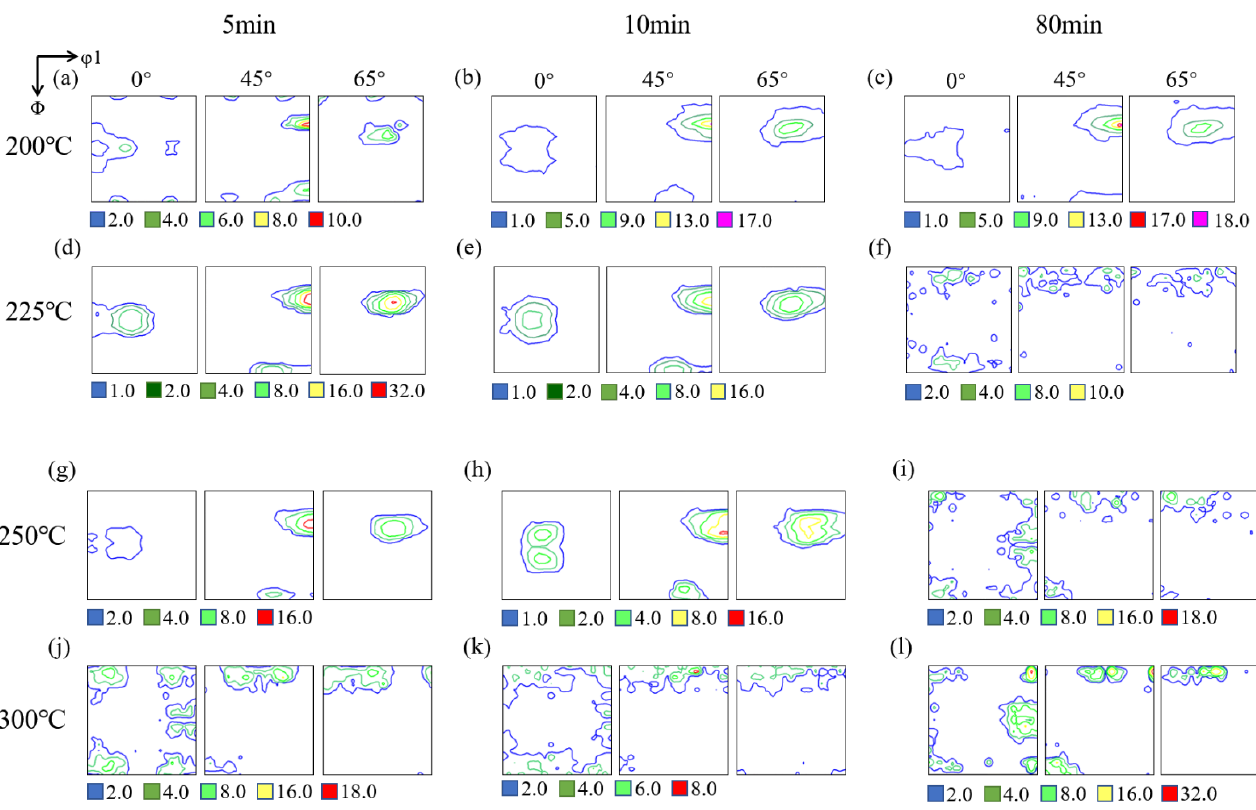
Figure 8. Textures evolution of cold-rolled Al-0.5%Cu samples after annealing in SH, the different colored boxes below represent the intensity of textures: ( a ) 200 °C, 5 min; ( b ) 200 °C, 10 min; ( c ) 200 °C, 80 min; ( d ) 225 °C, 5 min; ( e ) 225 °C, 10 min; ( f ) 225 °C, 80 min; ( g ) 250 °C, 5 min; ( h ) 250 °C, 10 min; ( i ) 250 °C, 80 min; ( j ) 300 °C, 5 min; ( k ) 300 °C, 10 min; ( l ) 300 °C, 80 min.